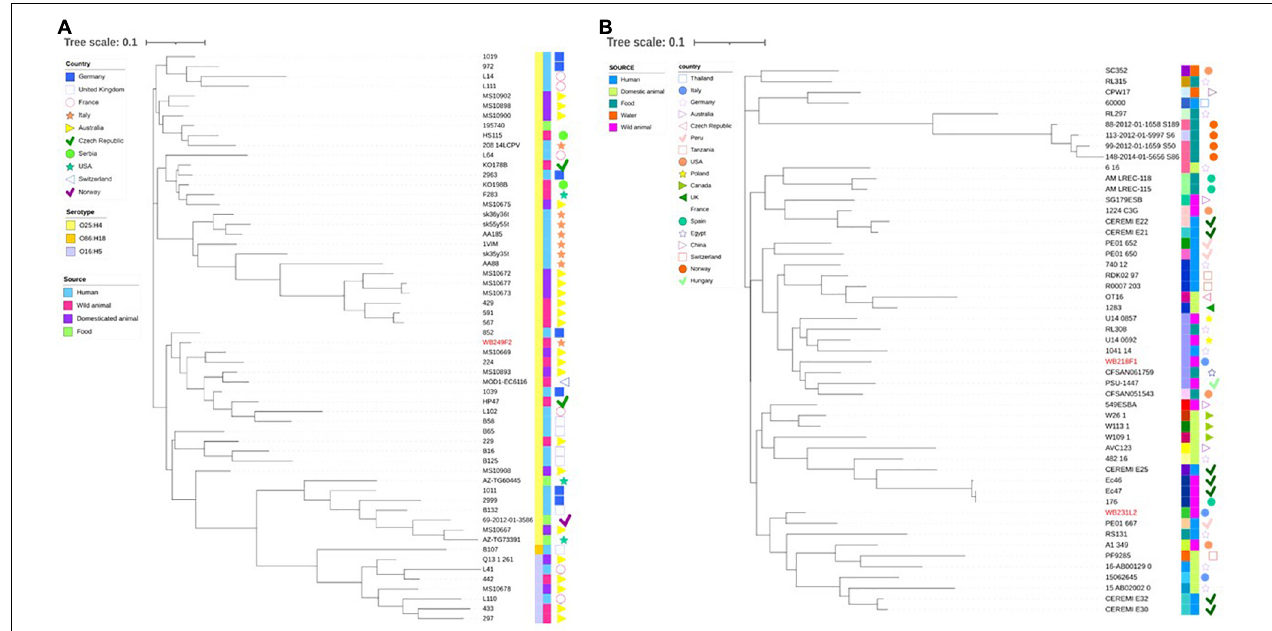
FIGURE 4 | Phylogenetic tree built on the SNPs of core genes in the ST131 (A) and ST10 (B) ES β L-producing E. coli strains analysed. (A) WB249F2, the ST131 strain isolated from wild boar, was compared with other 57 strains selected by isolation source and country, and (B) the same analysis was performed comparing WB218F1 and WB231L2 with other 49 strains, chosen following the same criteria. The wild boar isolates are highlighted in red in order to better evidence them. Colour-coding is used to report the serotype (first line) and isolation source (second line), while isolation countries are represented by different